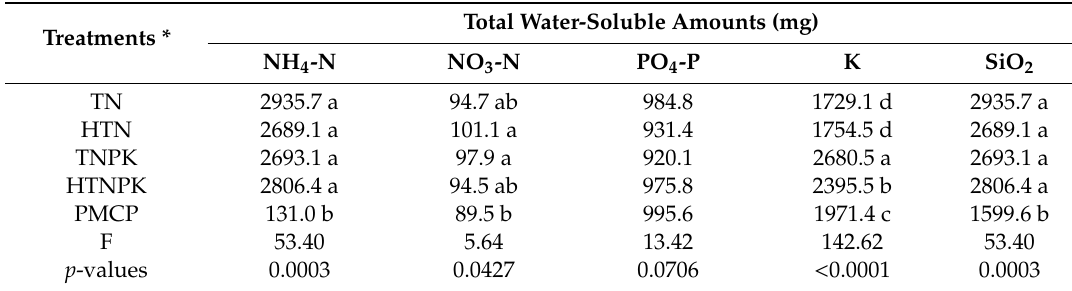
Table 8. Comparisons of the total water-soluble accumulated amounts of NH 4 -N, NO 3 -N, PO 4 -P, K, and SiO 2 for di ff erent treatments during the precipitation